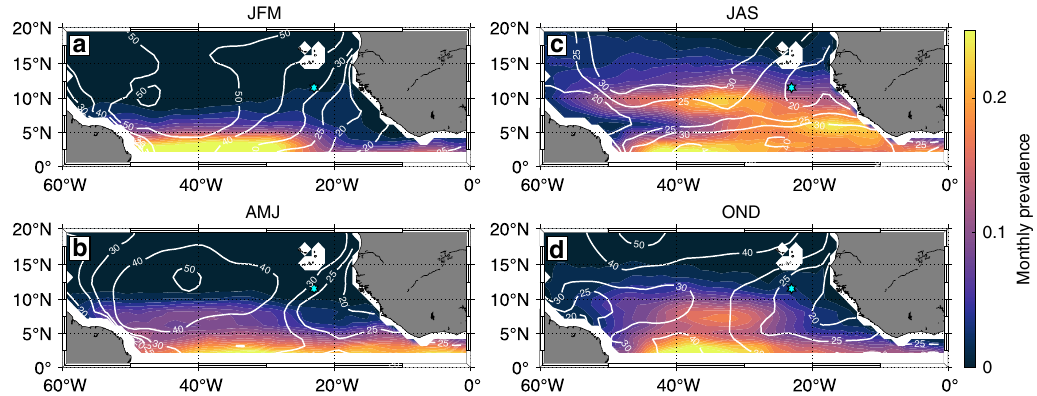
Fig. 8 Seasonal climatology of inertial activity in the tropical North Atlantic. The monthly prevalence of the inertial activity (IA) index crossing the threshold for α = 2 is averaged over the respective seasons. White contours represent the seasonal MIMOC mixed layer depth climatology 81 . The cyan star marks the position of the PIRATA buoy at 11.5°N, 23°W. a JFM: January – March, b AMJ: April – June, c JAS: July – September, and d OND: